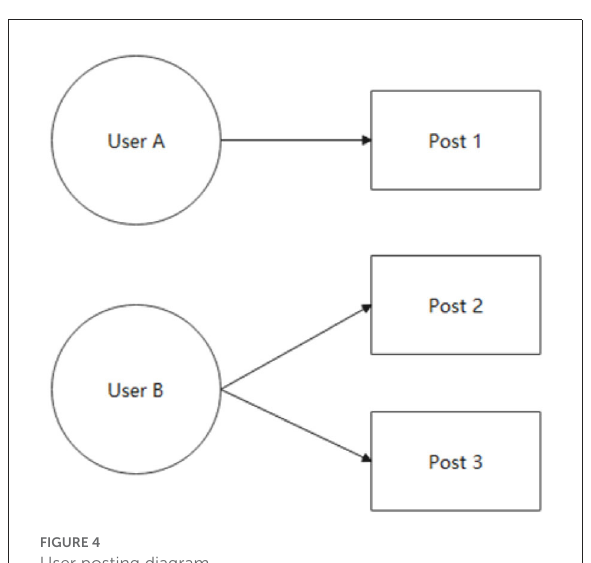
FIGURE4 User posting